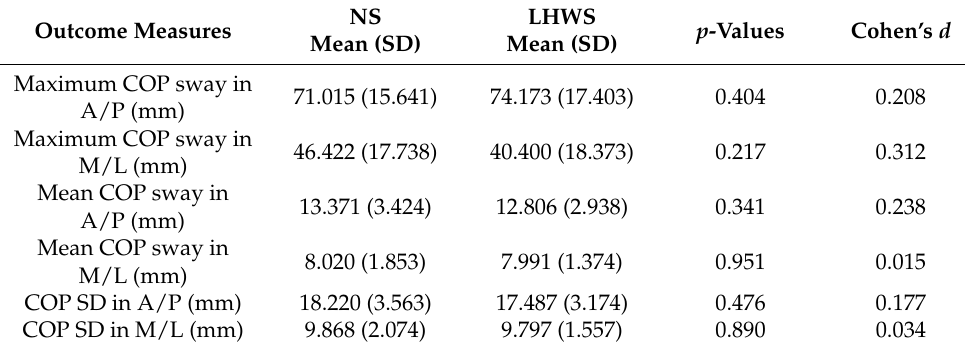
Table 2. Outcome measures derived from the center of pressure.